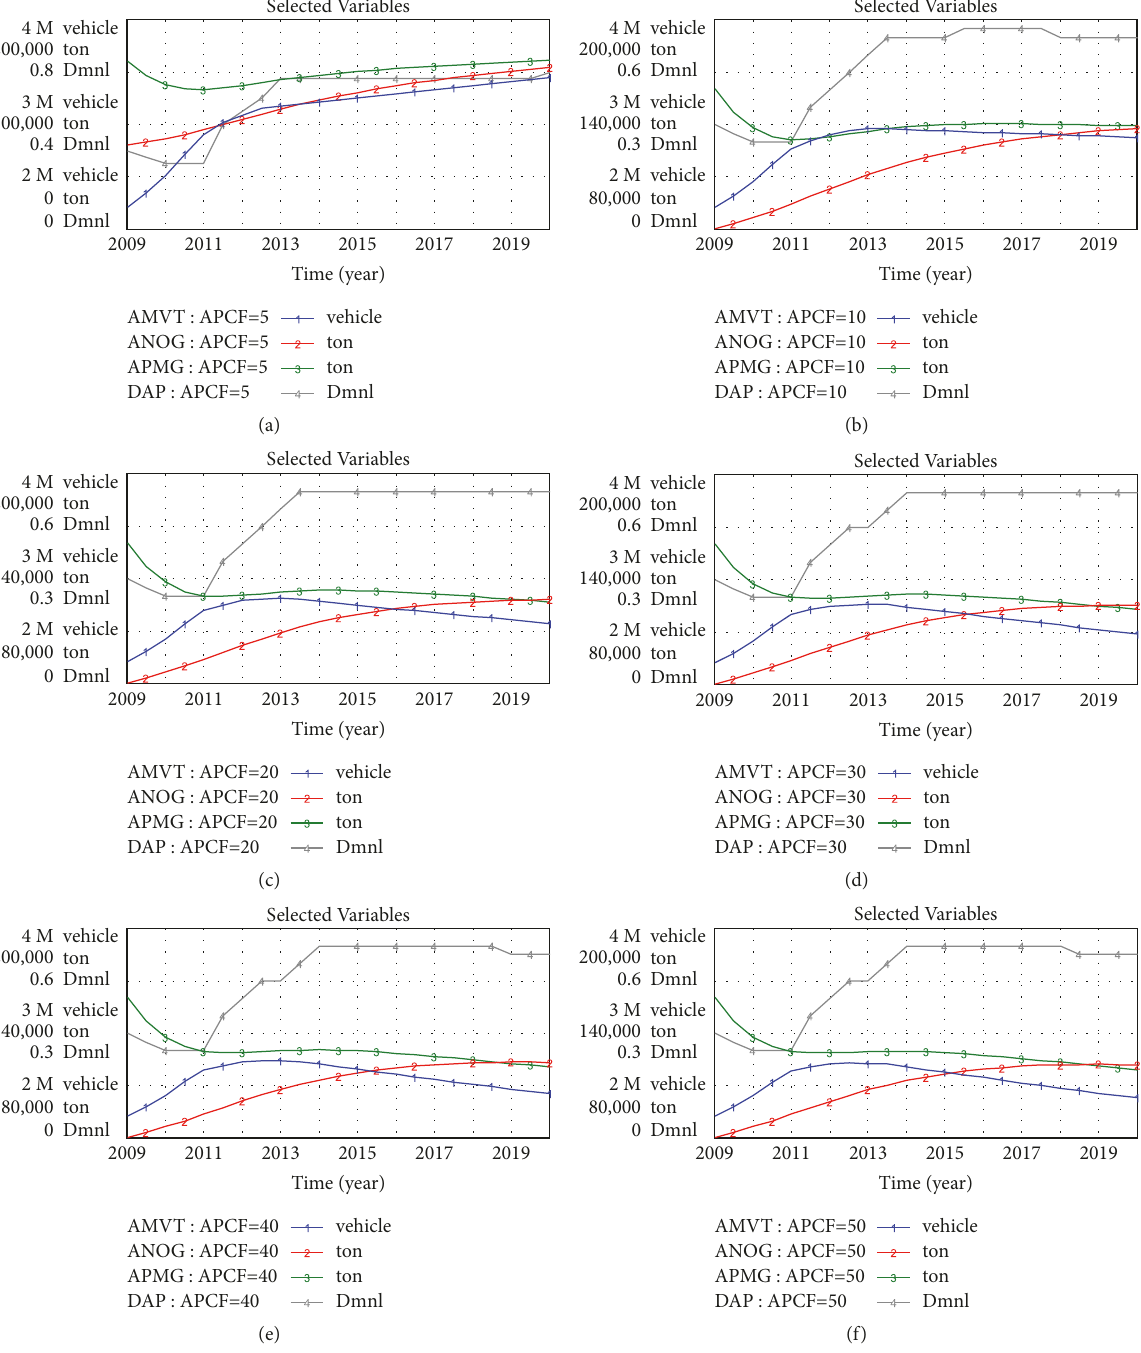
Figure 6: Policy simulation. (a) APCF=5. (b) APCF=10. (c) APCF=20. (d) APCF=30. (e) APCF=40. (f)